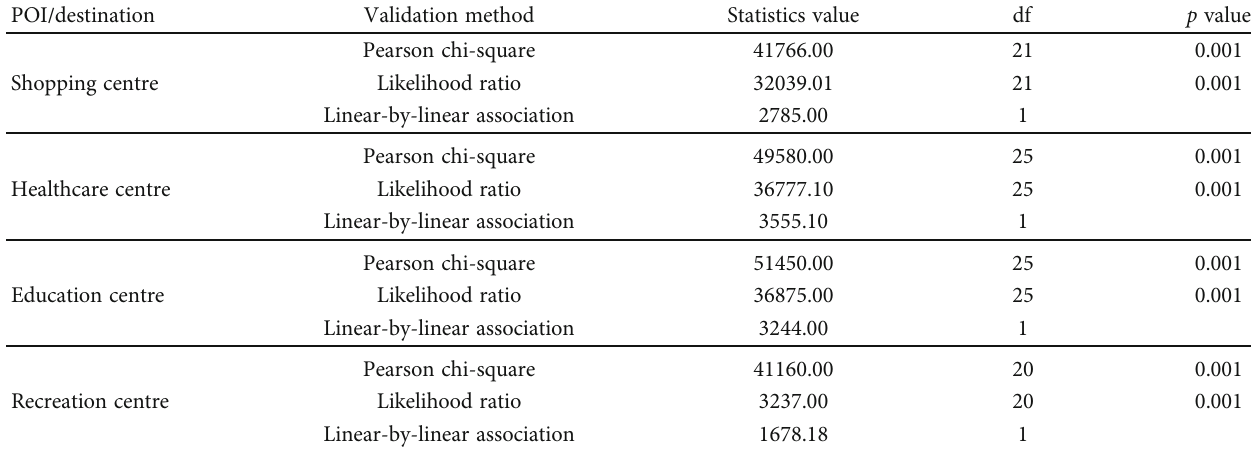
Table 5: Chi-square test results.